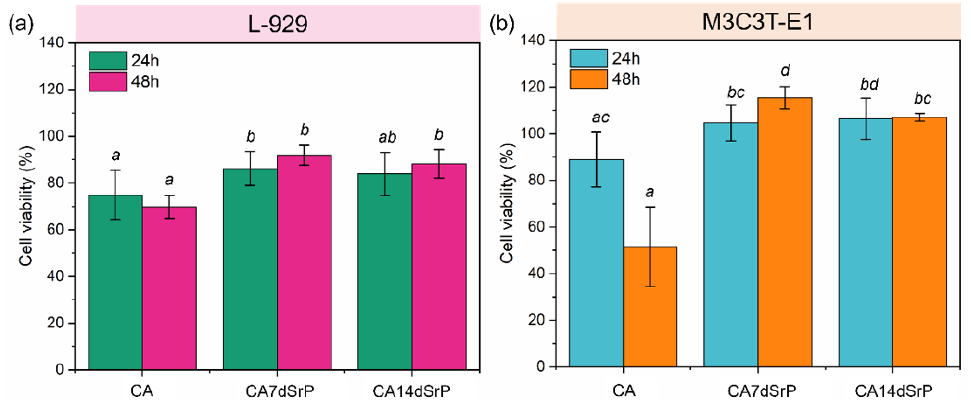
Figure 9. L-929 mouse fibroblast ( a ) and MC3T3-E1 osteoblast ( b ) viability of CA, CA7dSrP, and CA14dSrP after 24 and 48 h. Letters inside the graphs indicate homogeneous groups (treatments with non-significant differences). Two-way ANOVA followed by Tukey’s post-hoc multiple comparison tests were performed for statistical analysis of fibroblasts data, while the Kruskal–Wallis test was performed for the osteoblast data. A p -value of <0.05 was considered significant.